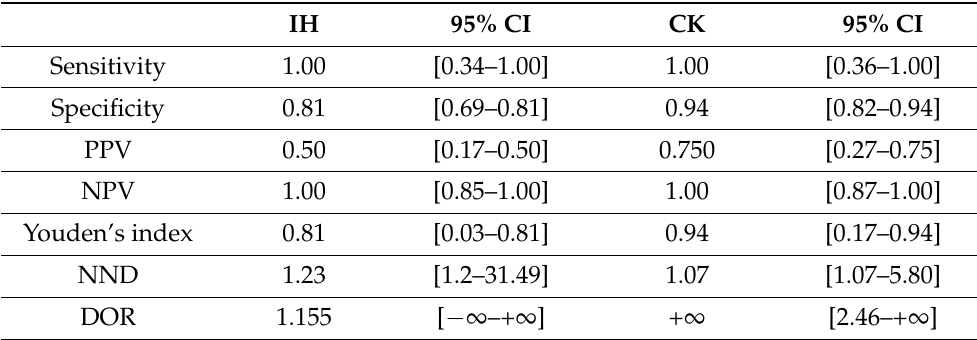
Table 6. Diagnostic indices of the IH and CK-PCR assays on ( n = 19) nail samples compared to conventional methods as the gold standard.